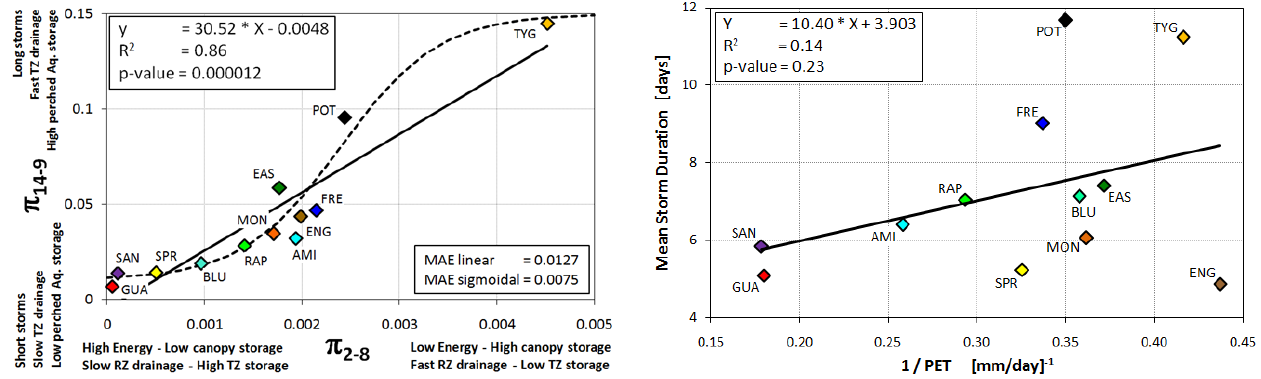
Figure 12 : Top: relationship between two dimensionless numbers characterizing co-variation between climate forcing, canopy storage and belowground storage and release characteristics of the 12 catchments. The data suggest either a linear or a sigmoid functional relationship, with MAE (mean absolute error) smallest for the latter; Bottom: Lack of significant relationship between mean storm duration and potential evapotranspiration illustrating that trend in top panel is not due to climate gradient only.